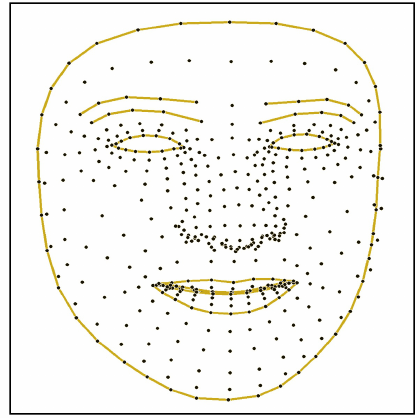
Figure A1. Face Mesh keypoints